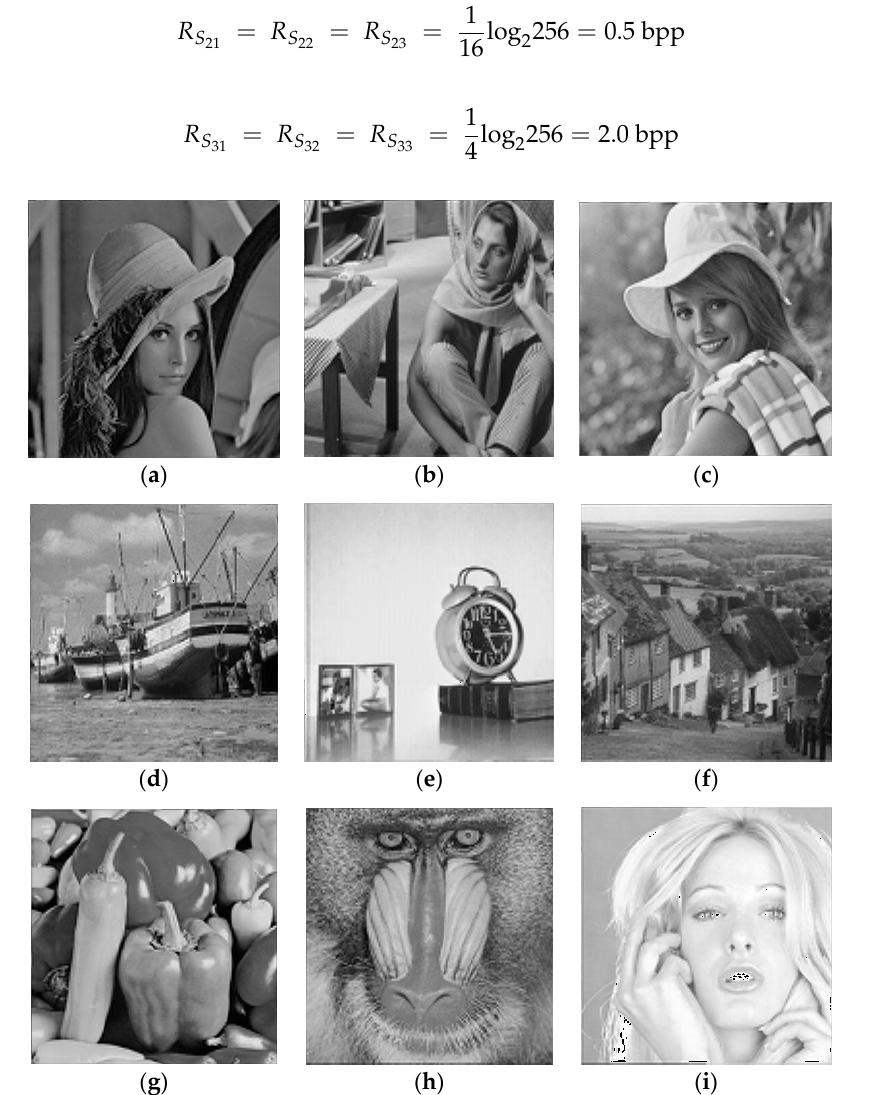
Figure 3. Images obtained from the inverse discrete wavelet transform with the exclusion of subbands S 11 , S 12 and S 13 . ( a ) Lena PSNR = 30.05 dB; ( b ) Barbara PSNR = 25.54 dB; ( c ) Elaine PSNR = 31.88 dB; ( d ) Boat PSNR = 26.07 dB; ( e ) Clock PSNR = 29.02 dB; ( f ) Goldhill PSNR = 27.77 dB; ( g ) Peppers PSNR = 30.74 dB; ( h ) Mandrill PSNR = 24.93 dB; ( i ) Tiffany PSNR = 31.69 dB.